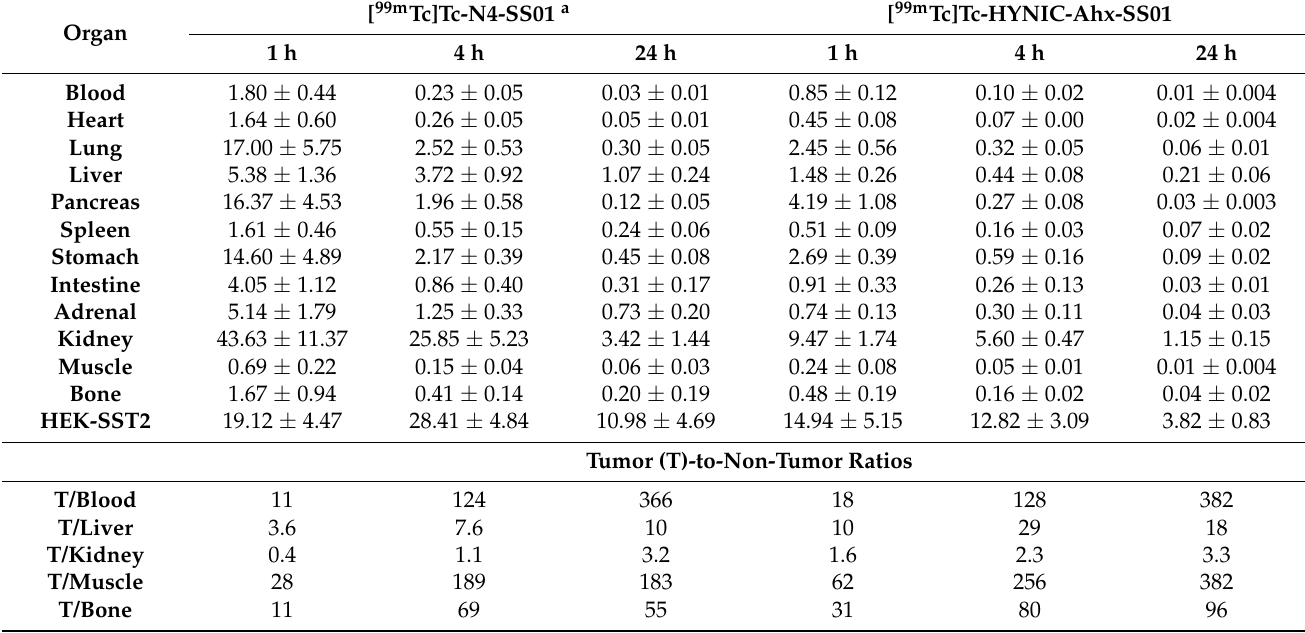
Table 2. Biodistribution studies of [ 99m Tc]Tc-N4-SS01 and [ 99m Tc]Tc-HYNIC-Ahx-SS01 in SST2-expressing xenografts at 1 ( n = 4), 4 ( n = 4) and 24 ( n = 3) hours p.i. Results are expressed as mean of the % injected activity per gram of tissue (% IA/g) ± standard deviation